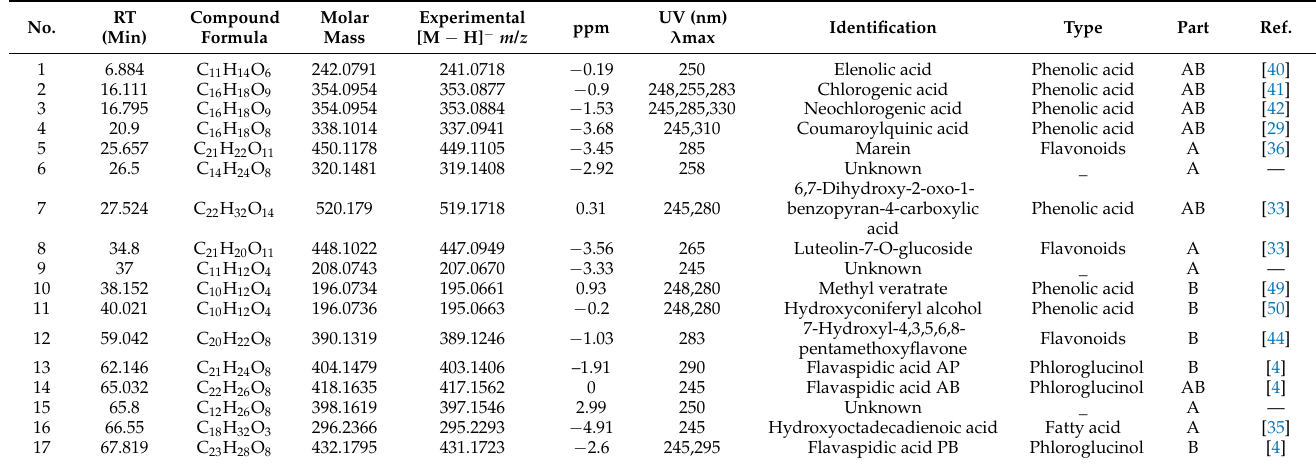
Table 2. Qualitative analysis of nonvolatile components of D. crassirhizoma by